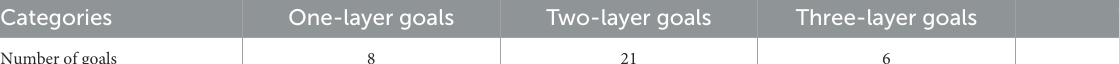
TABLE 1 The number of goals in each goal category.